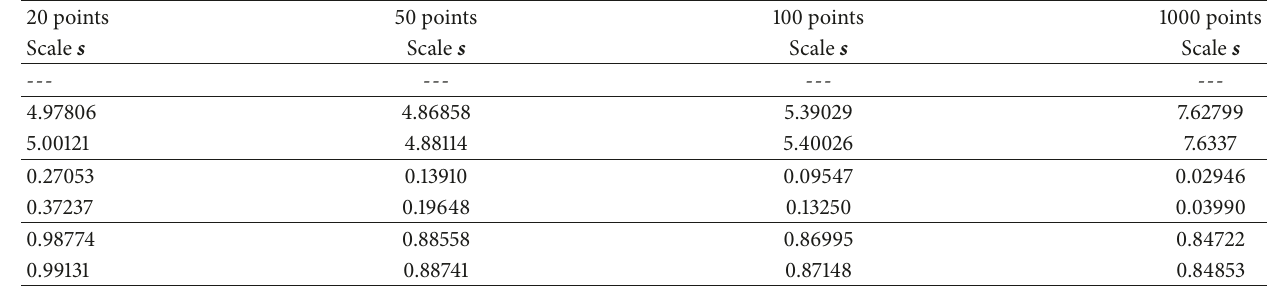
Table 67: G-h distributions with 50% noise level.